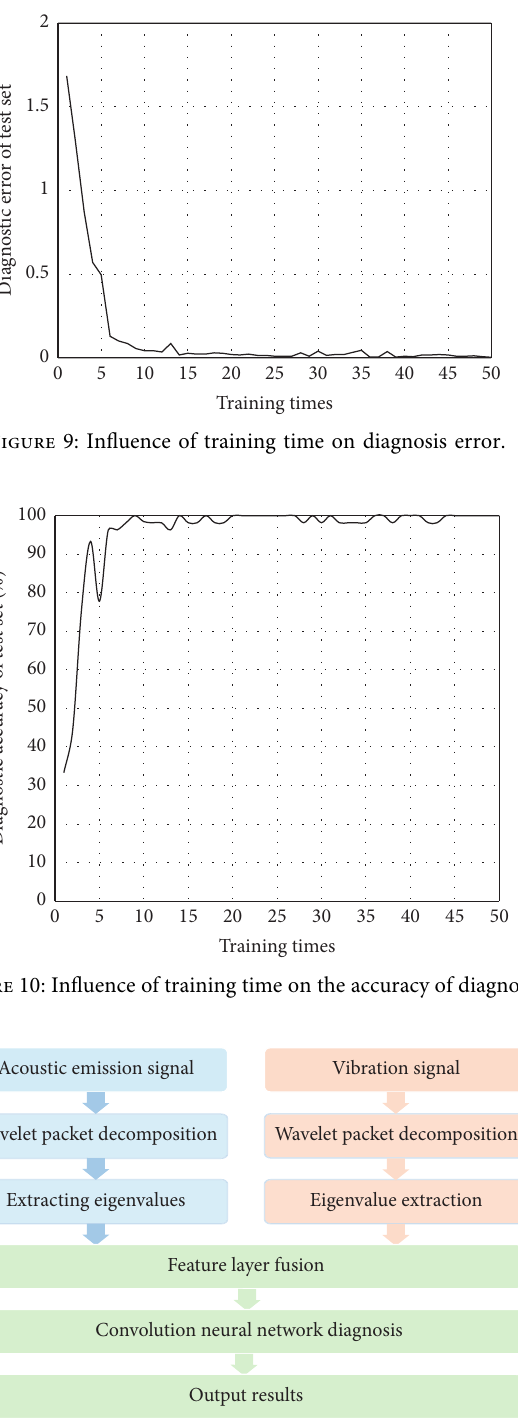
Figure 11: Bearing fault diagnosis process based on deep learning and information fusion.